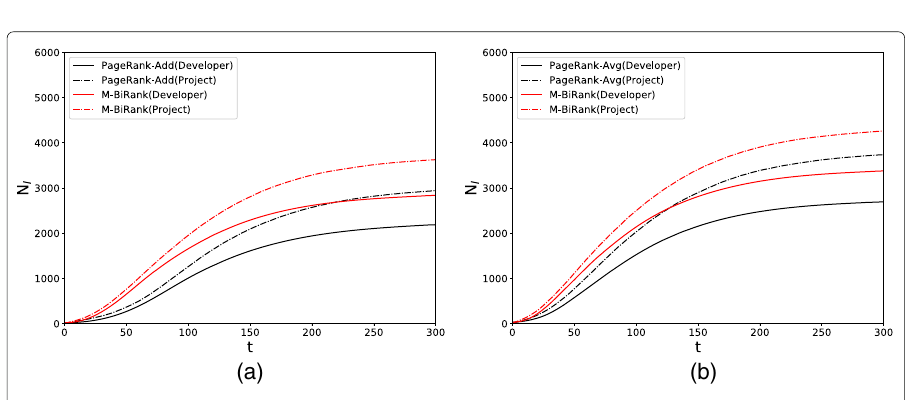
Fig. 5 Performance comparison between M-BiRank and PageRank. The horizontal axis t indicates the number of iterations in SIR modeling. The vertical axis N I indicates the number of final infected nodes (developers or projects, including infected and removed nodes)